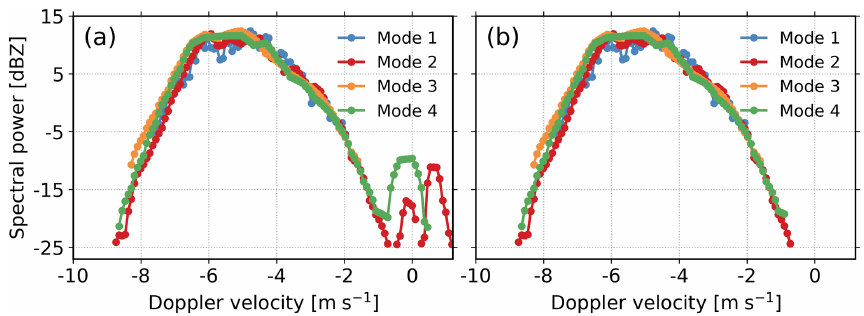
Figure 1. (a) Noise-removed Ku-band Doppler power spectrum on 6 June 2020 at 22:52:08LST at the range of 2.34km. (b) Same as (a) but decluttered with our clutter mitigation algorithm. The unit of Doppler power spectral density data is mm 6 m − 3 (ms − 1 ) − 1 ; we simply use the unit “dBZ” here and after to denote spectral power in the dB scale.